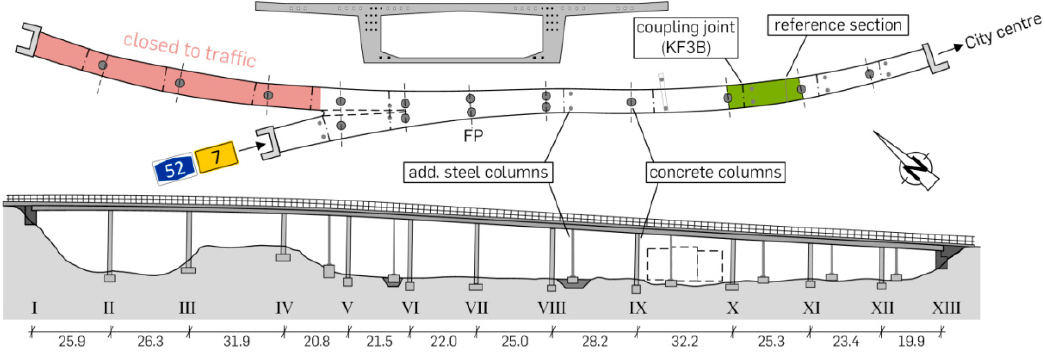
Figure 2. Reference structure Pariser Straße in Düsseldorf, Germany—side and top views along with a general cross-section.